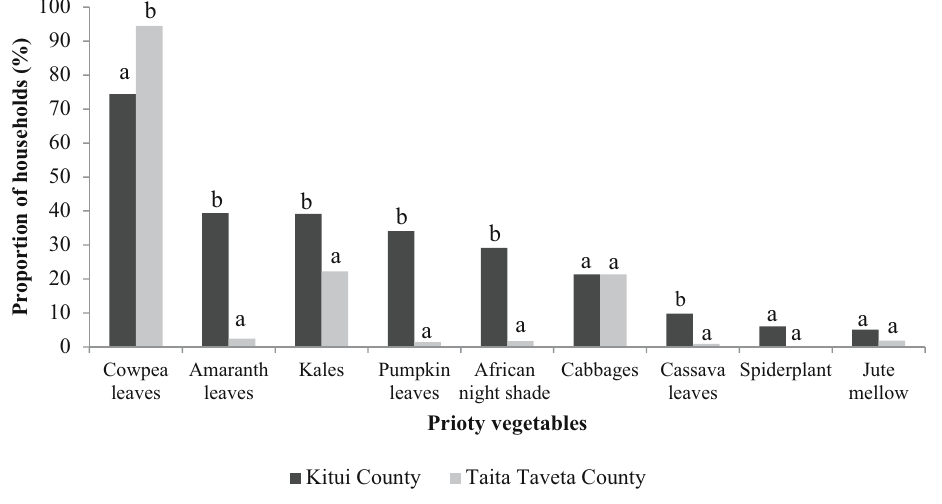
Figure 2: Priority vegetables in the study areas. Di ff erent letters for an attribute indicate signi fi cant di ff erence at p <